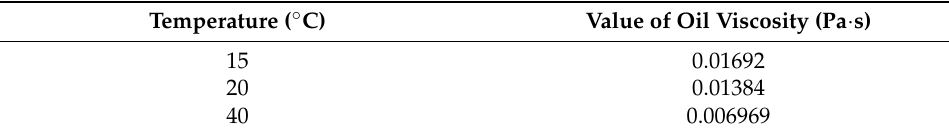
Table 5. Temperature-related changes in oil viscosity